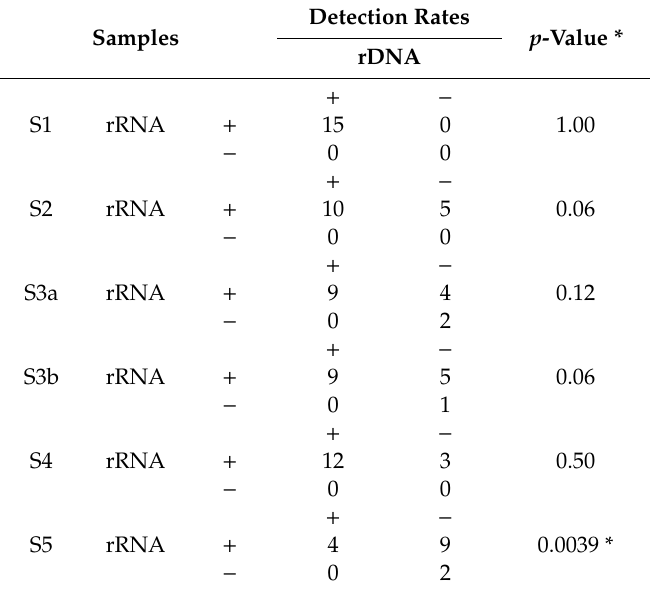
Table 3. Bacteria detection rates by qPCR assays targeting bacterial ribosomal RNA (rRNA) and the respective genes (rDNA) in root canal samples taken after access cavity (S1), root canal preparation (S2), XP-endo Finisher (S3a), passive ultrasonic irrigation (S3b), calcium hydroxide medication (S4) and 2nd-visit root canal preparation